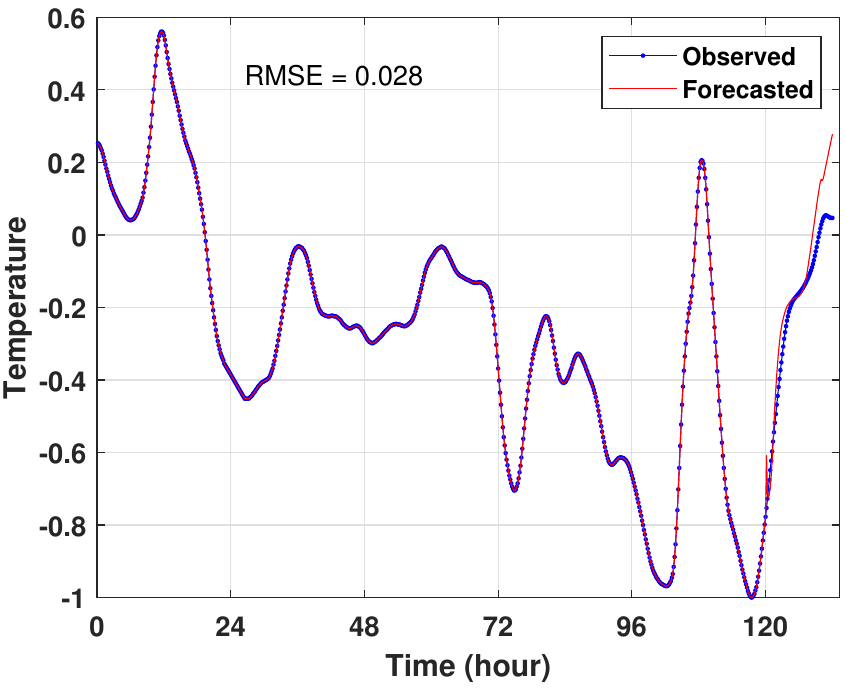
Figure 15. Temperature forecasting by LSTM.